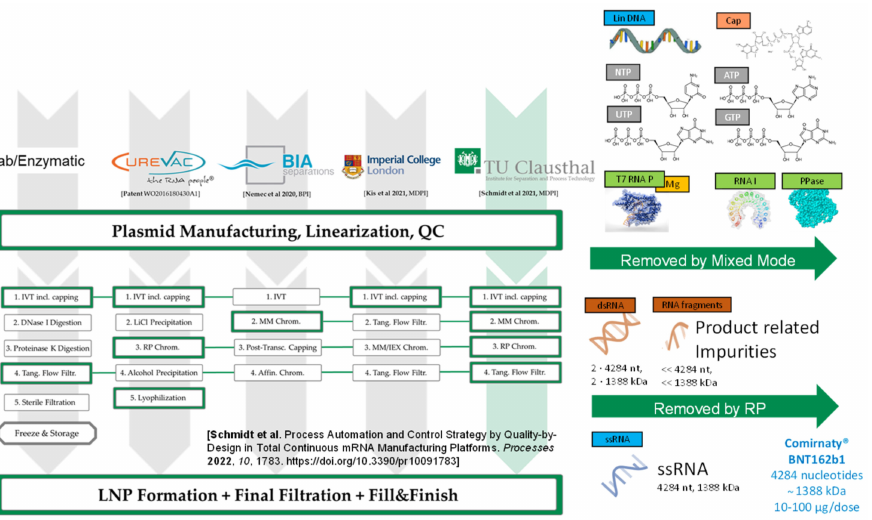
Figure 2. Comparison of different purification strategies as well as the route chosen for this study with molecules separated from the product per step